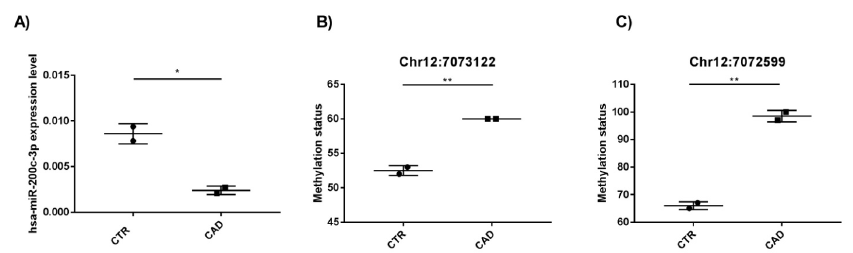
Figure 4. Integrated miRNA-sequencing and genome-wide methylation results on four selected sub-